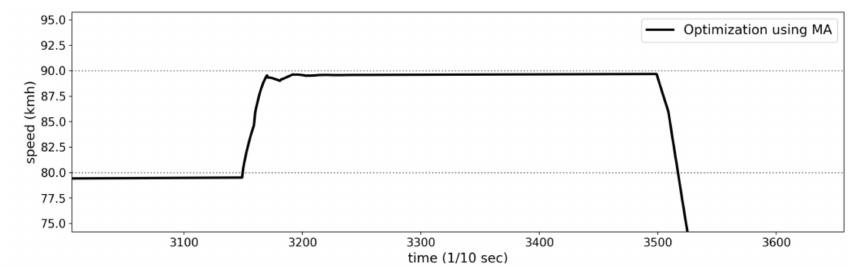
Figure 5. Detail of the performance of MA in one step response.